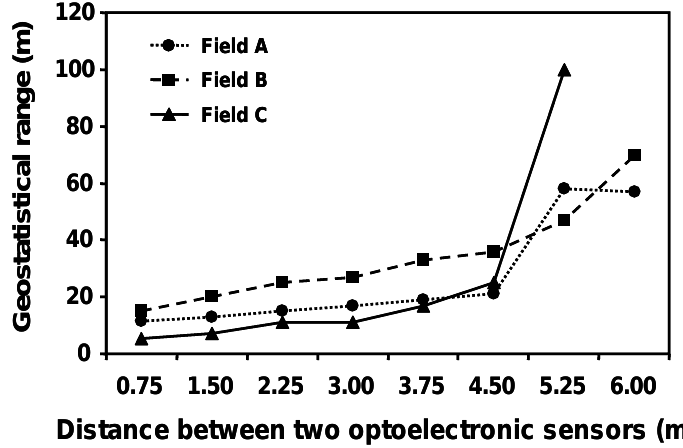
Figure 3. Estimates of the geostatistical range for the north-south direction (along crop rows) for weed maps constructed by the autonomous system derived from an exponential model. Three fields are compared: ● Field A (2.5 ha) heavily infested by weeds; ■ Field B (3.0 ha) and ▲ Field C (1.7 ha) with large portions of weed free